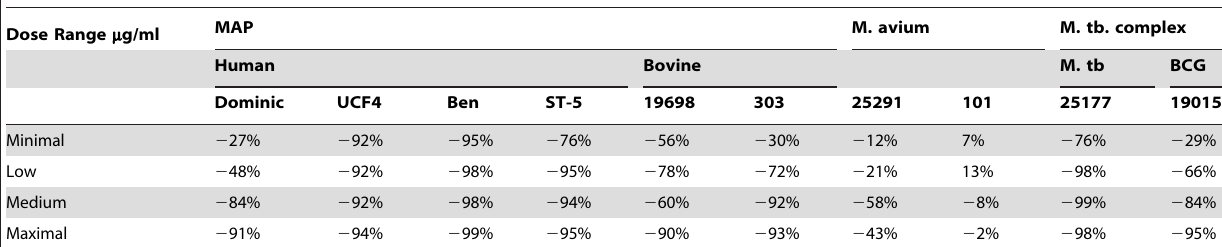
Dose Range m g/ml